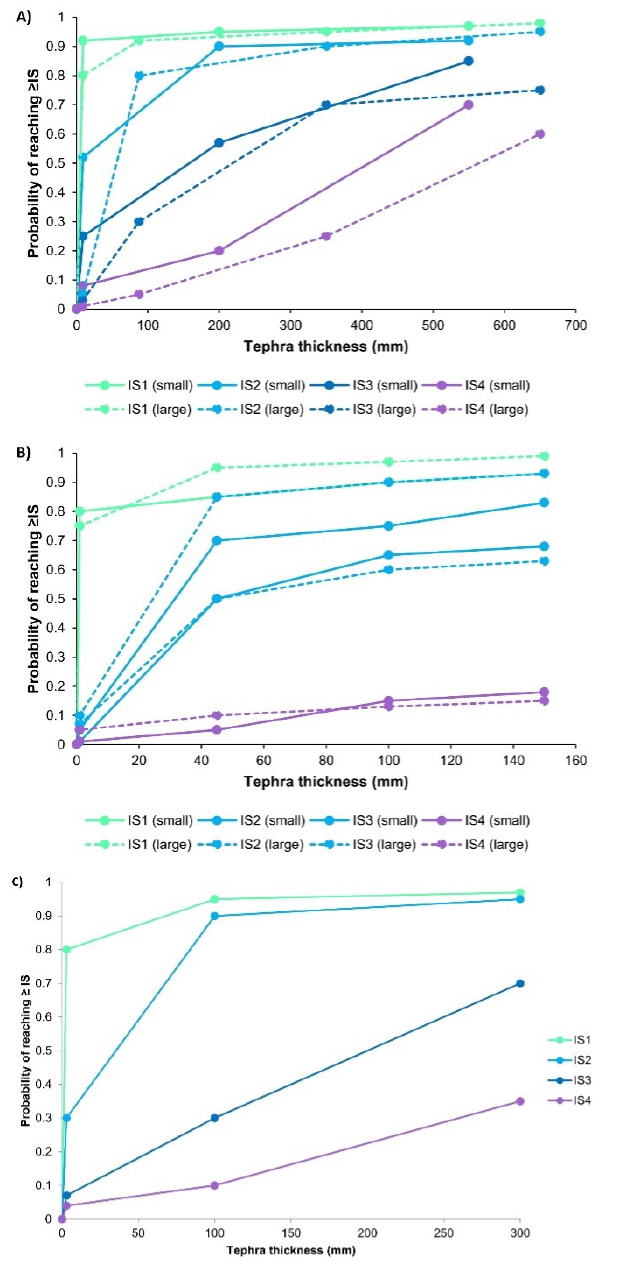
Figure 3: Pastoral fragility function suite for [A] high intensity, non-dairy pastoral farming fragility functions for small and large farms at full vulnerability; [B] low in- tensity, non-dairy pastoral farming fragility functions for small and large farms at full vulnerability; and [C] dairy farms at full vulnerability.